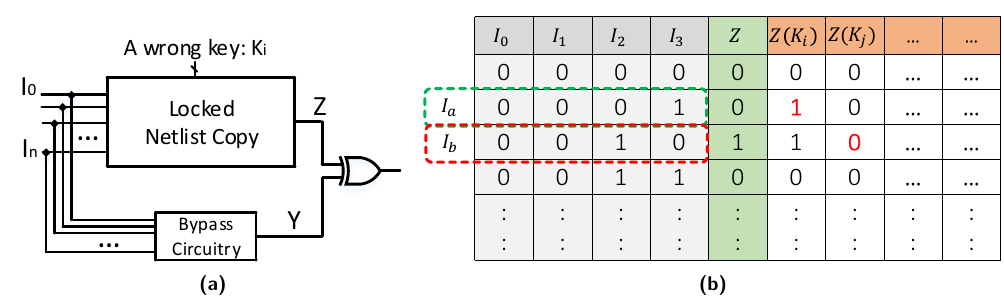
Figure 2: (a) shows that for a locked netlist, a bypass circuit can be inserted to detect the DIP for the wrong key K i . (b) shows an example truth table for finding the two DIPs with two wrong keys K i and K j for SARLock and Anti-SAT (Secure